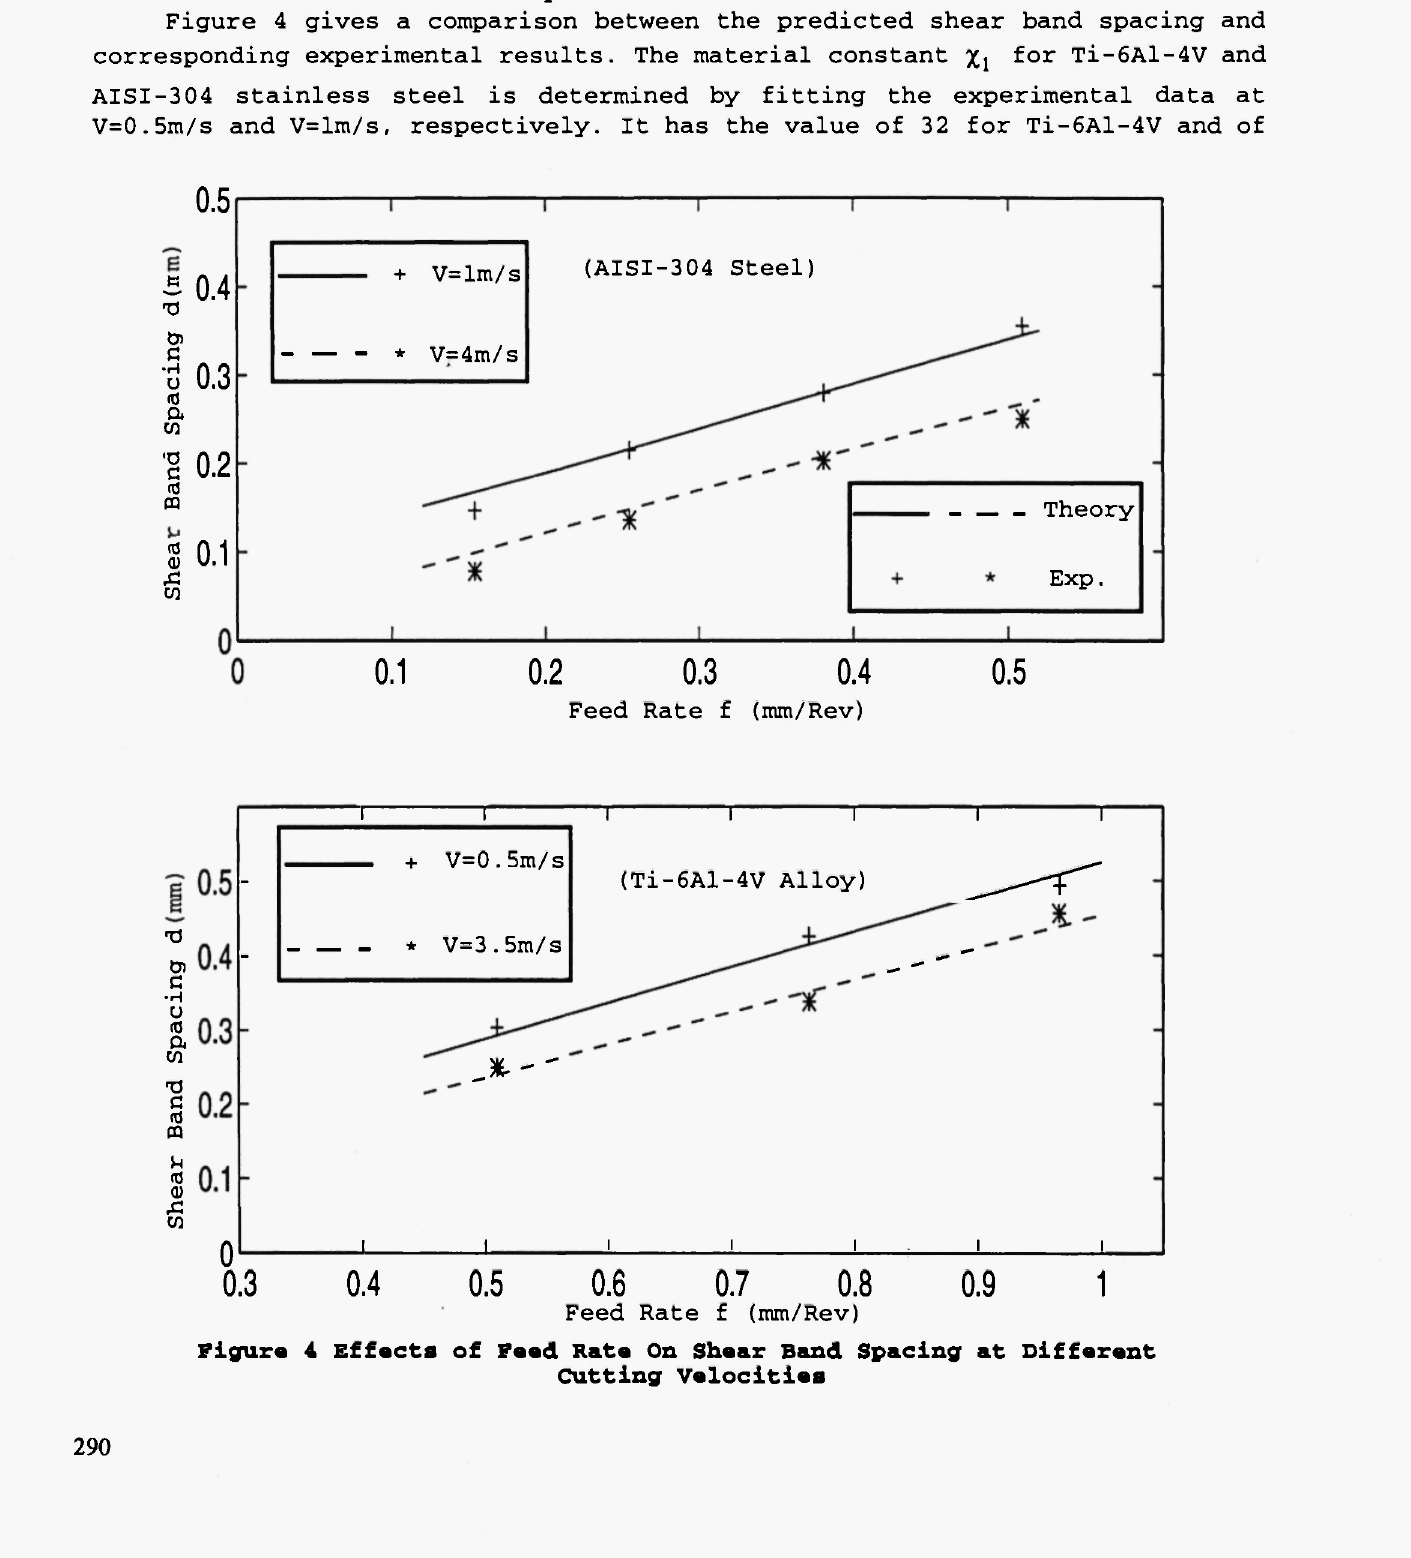
Figure 4 Effects of Feed Rate On Shear Band Spacing at Different Cutting